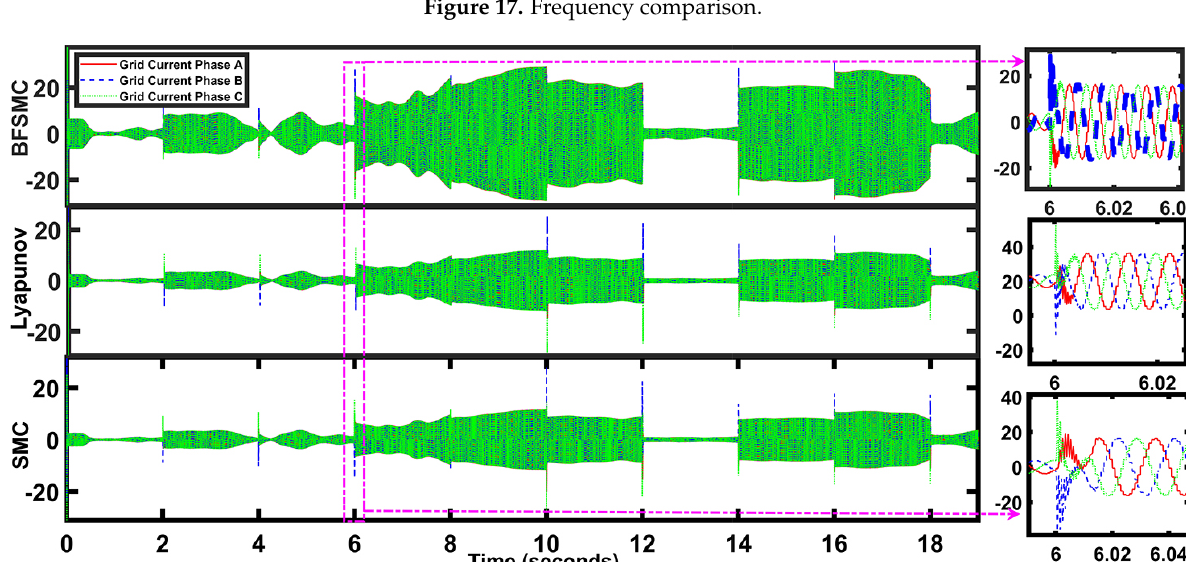
Figure 18. Grid current